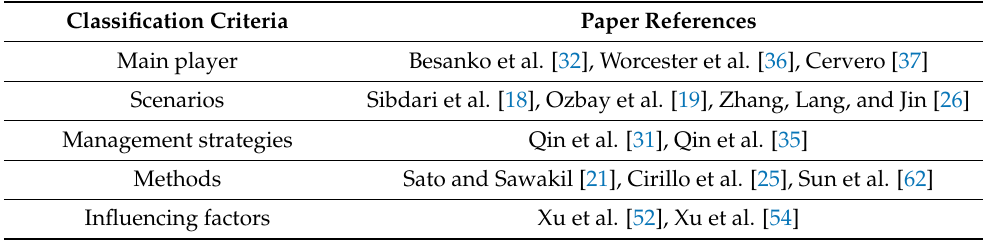
Table 3. Reference category corresponds to the three research questions. Classification